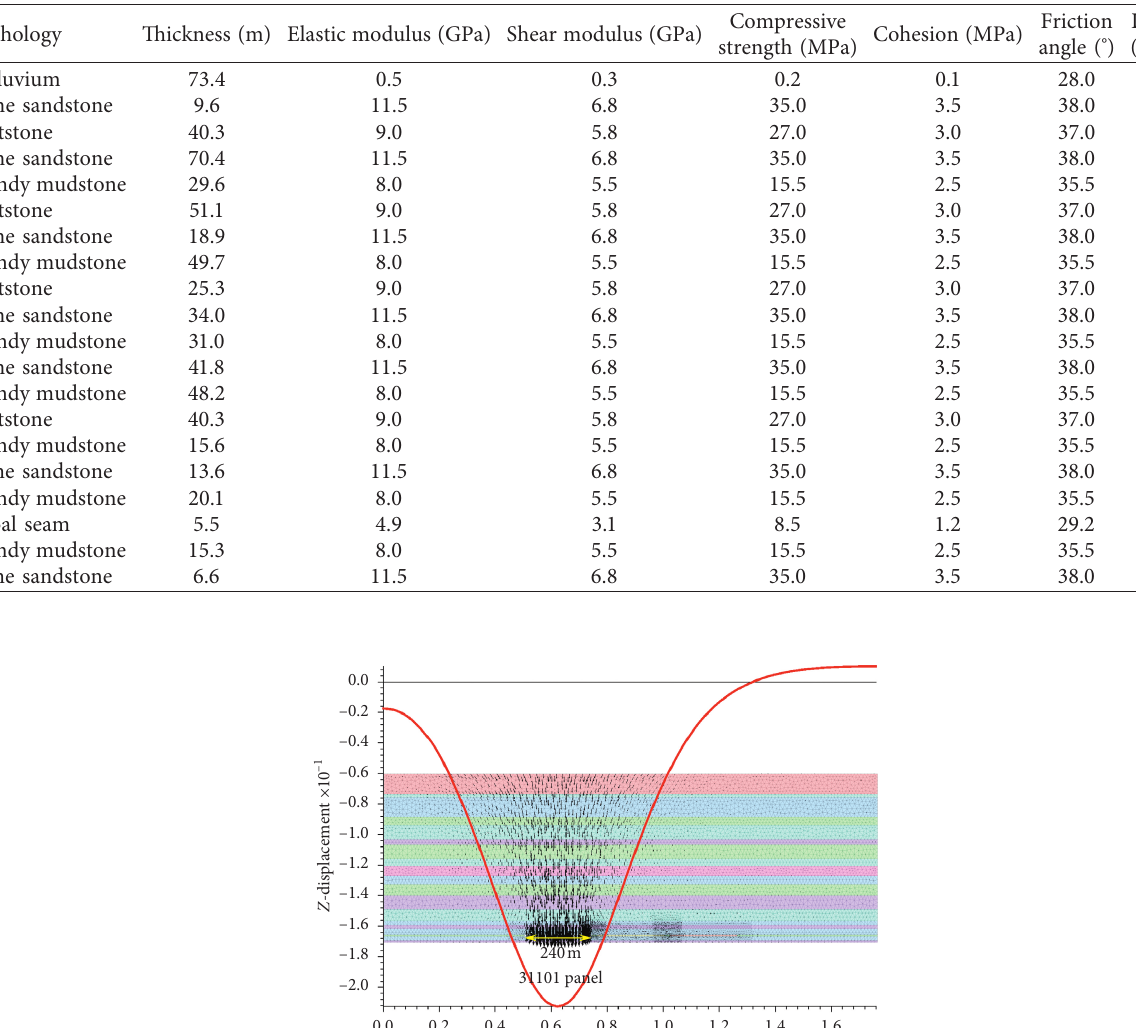
Table 8: Parameters used for strata.